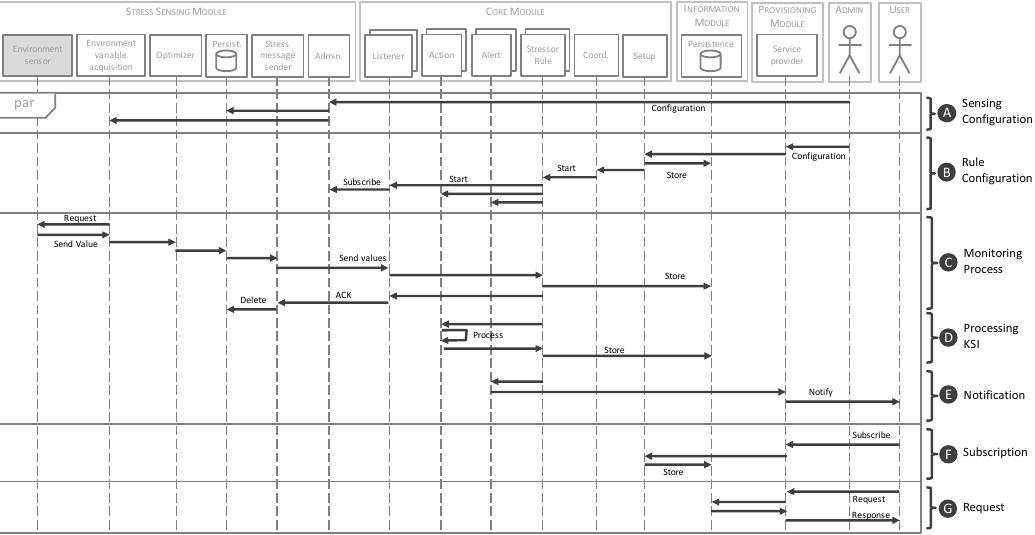
Figure 3. Sequence diagram of the main processes.